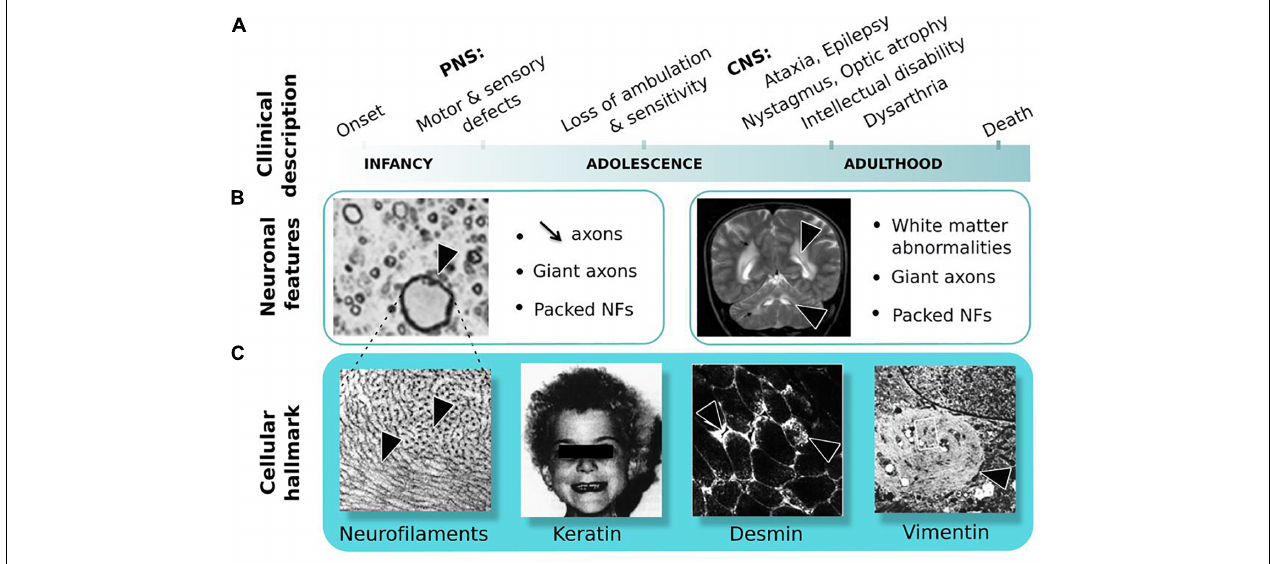
FIGURE 3 | Giant Axonal Neuropathy. (A) Symptoms are shown in order of occurrence: from onset in childhood in the peripheral nervous system (PNS) to adulthood in the central nervous system (CNS). (B) Neuronal features: (left) nerve cross-section in the PNS shows reduced axonal content and giant axon; (right) magnetic resonance imaging of the brain reveals white matter abnormalities. Giant axons of CNS are not represented here. (C) Cellular hallmark: (from left to right) accumulation and altered distribution of neurofilaments (NFs) in giant axons, curled hair, desmin bundles in muscles and aggregates of vimentin in skin-derived fibroblasts. Copyright with permission from BioMed Central, Springer and